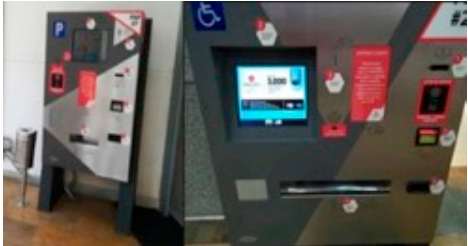
Figure 8. General overview and detailed closeup of interface on self-service checkout in Home Center in Bogotá, Colombia.